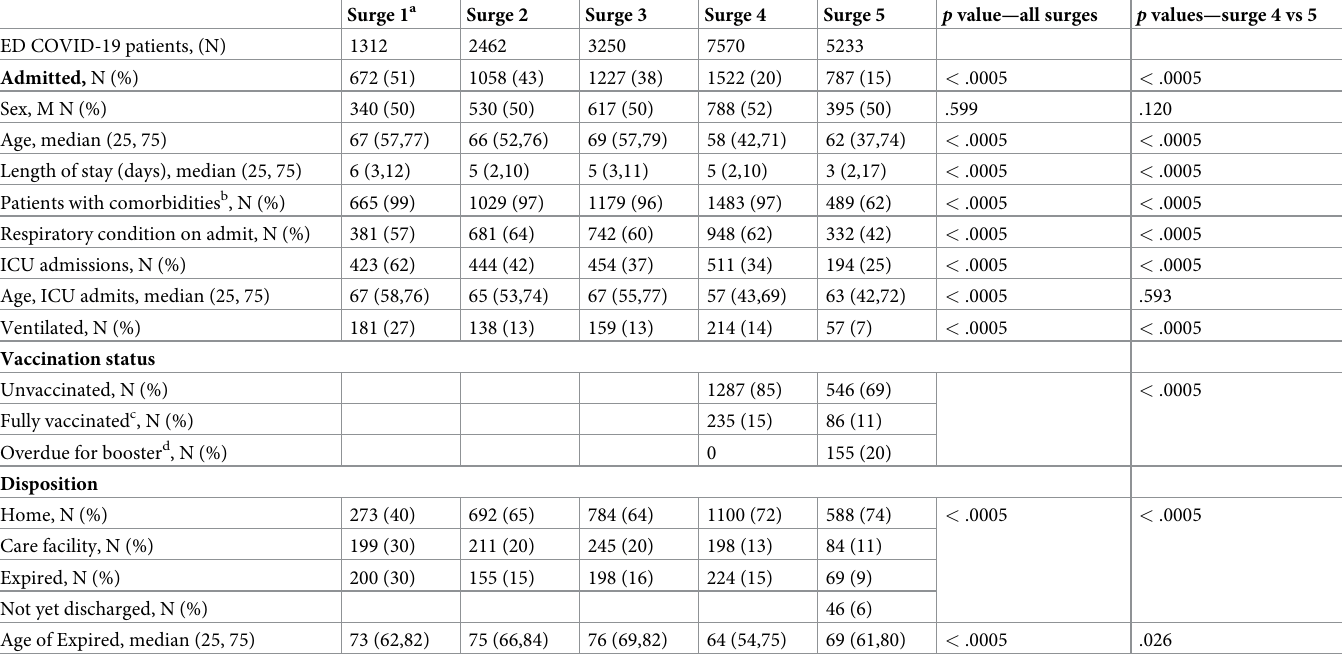
Table 1. Comparison of characteristics and outcomes in all patients admitted with COVID-19 over the pandemic. Surge 1 a Surge 2 Surge 3 Surge 4 Surge 5 p value—all surges p values—surge 4 vs